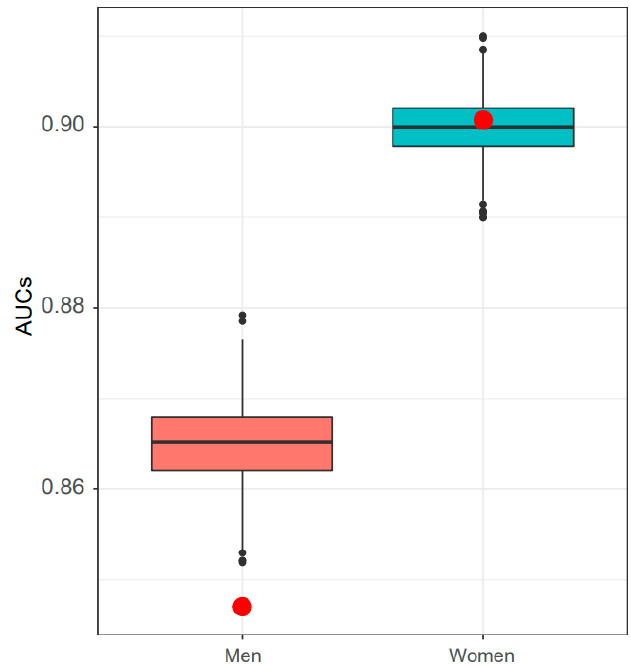
Figure 2. Classification performance of the sex-specific hypertension classification model. A boxplot includes 1000 bootstrapped derivation datasets (i.e., KNHANES 2011–2015). Red points indicate the classification performance obtained from the internal validation dataset (i.e., KNHANES 2016– 2018). Abbreviations: AUC, area under the curve; KNHANES, Korea National Health and Nutrition Examination Survey.